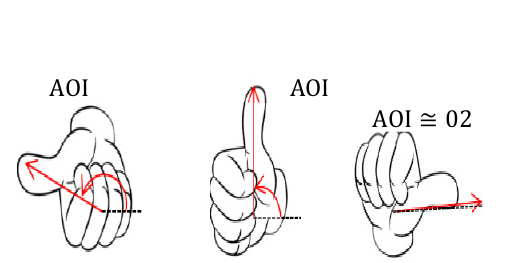
Fig. 8: The Three Fist Postures with the approximate AOI posture, the vector containing the single AOI feature is forwarded to the SVM classifier for training (in learning phase) or for classification (in application phase). The effective ML classifier; SVM [42, 43] is used to learn distinct fist-postures on the basis of AOI.